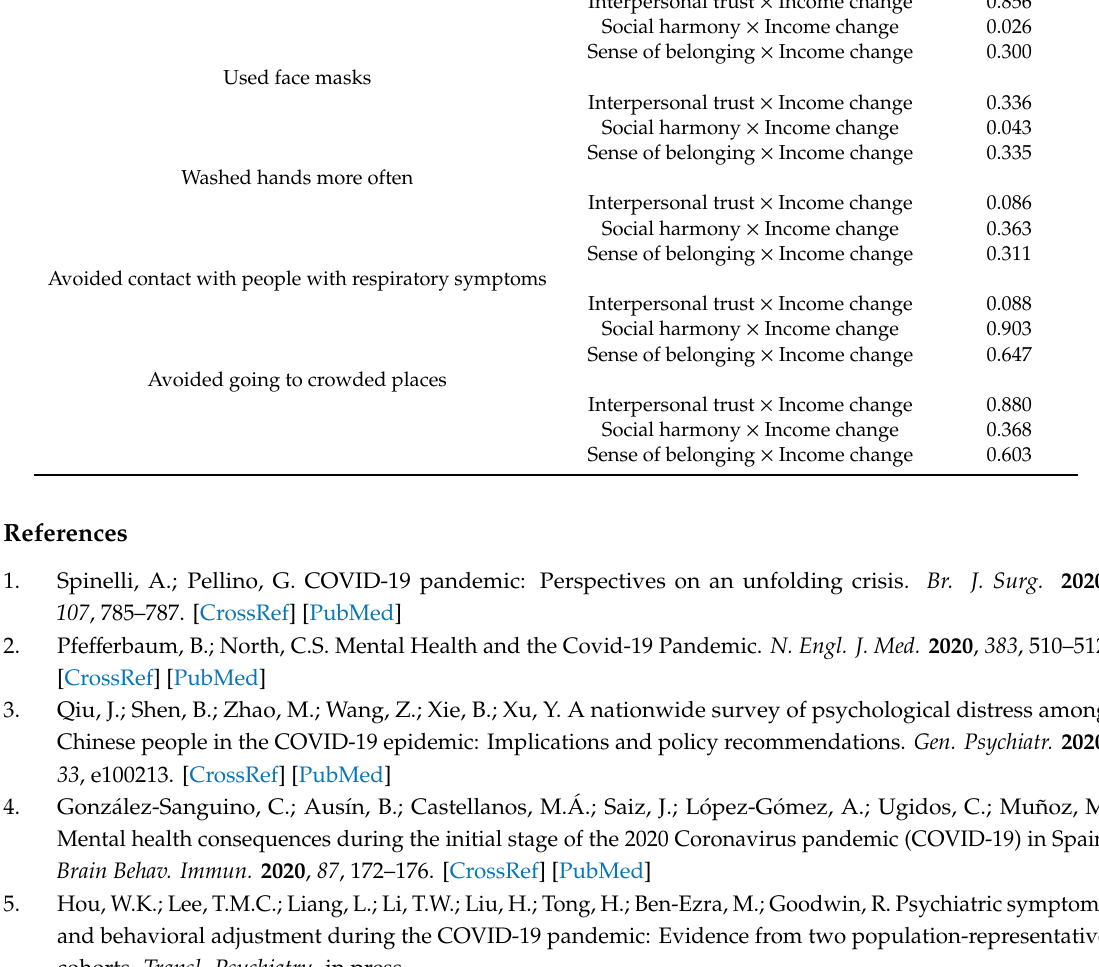
Table S1: Multivariable logistic regression examining the associations of social capital with probable depression and adoption of preventive behaviors among respondents aged 18 or above (n = 2921), Table S2: Interaction e ff ects of social capital and income change on probable depression and adoption of preventive behaviors among respondents aged 18 or above (n = 2921).